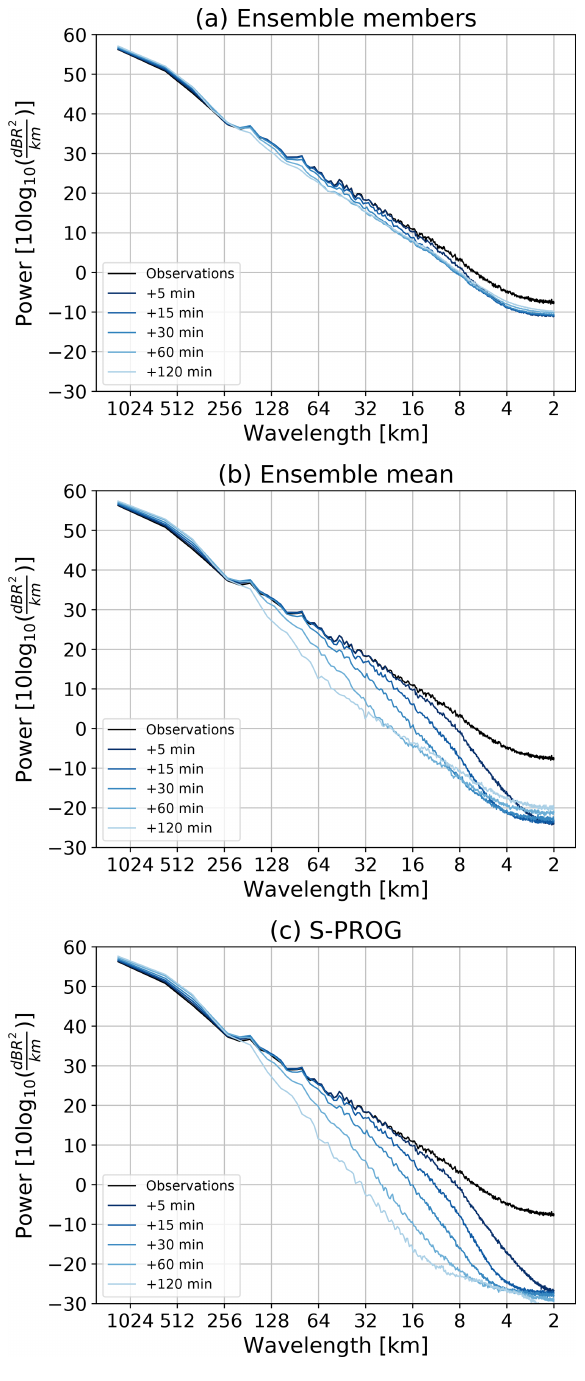
Figure 9. Spatial structure analysis of (a) stochastic ensemble mem- bers, (b) ensemble mean and (c) S-PROG filtering. To be compara- ble, the incremental mask and probability matching were used for both the ensemble mean and S-PROG nowcasts. All nowcasts used the Lucas–Kanade optical flow on the same event of Fig. 8. The en- semble is composed of 48 members. All models used a cascade of eight levels without motion perturbations.